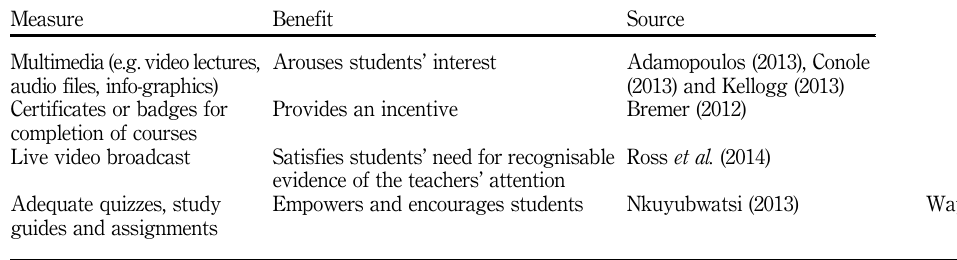
Table II. Ways to